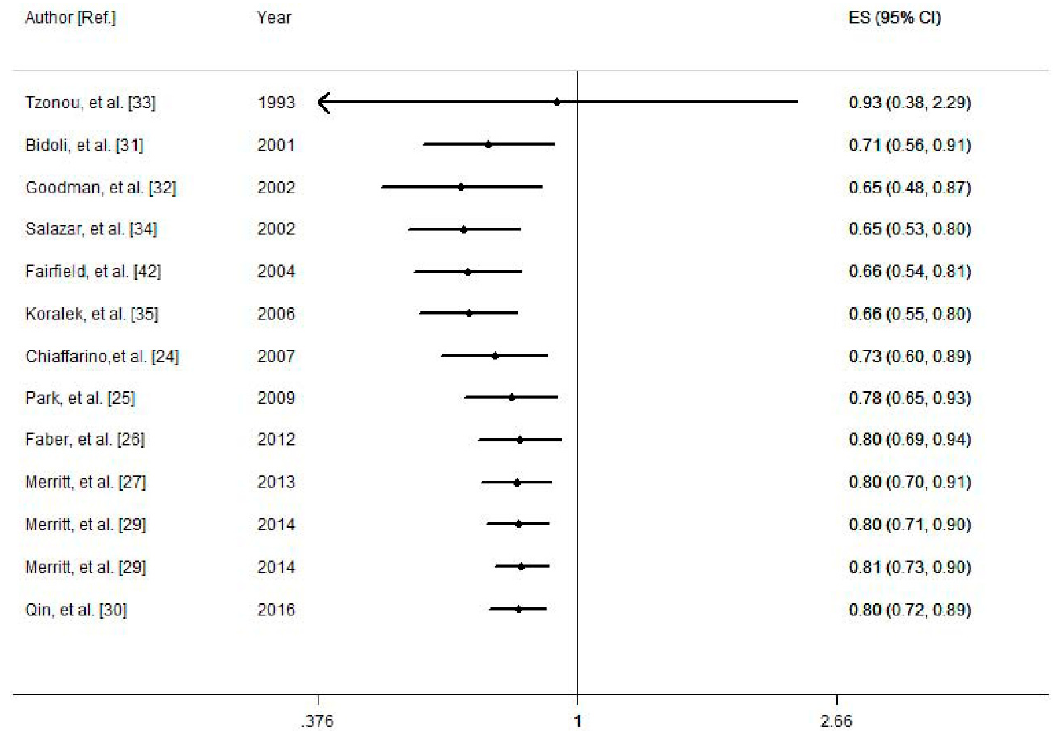
Figure 3. Cumulative meta-analysis of the association between dietary calcium intake and ovarian cancer risk. Open circle indicates the pooled relative risks, horizontal line represents the 95% confidence intervals.